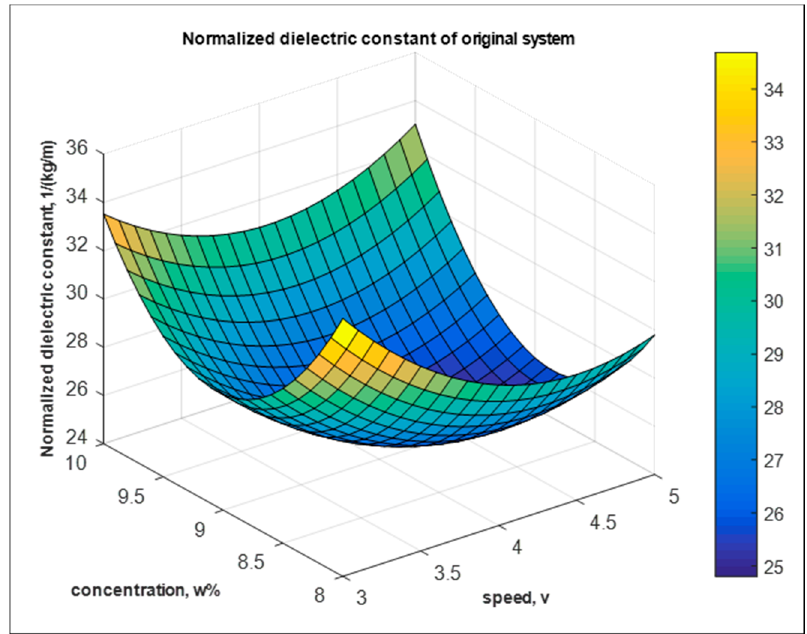
Figure 18. Fitted model of normalized dielectric constant from the original system.